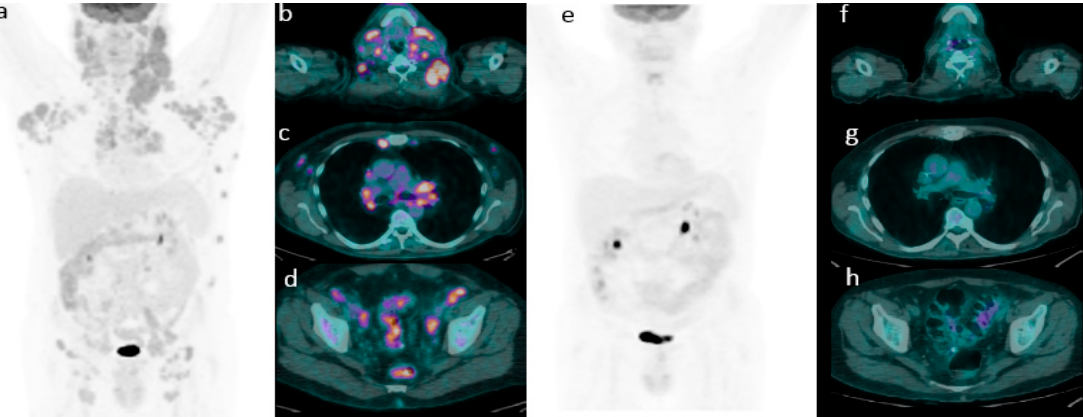
Figure 1. Emblematic example of complete metabolic response. A representative case of a 56-year-old male with stage III MCL. ( a ) Baseline maximum intensity projection (MIP), showing diffuse hypermetabolic disease in ( b ) laterocervical, ( c ) mediastinal and ( d ) iliac nodes. ( e ) PET/CT after chemotherapy showing a complete metabolic response (Deauville score 1) with no 18F-FDG uptake ( f – h ) with the disappearance of previous lesions.